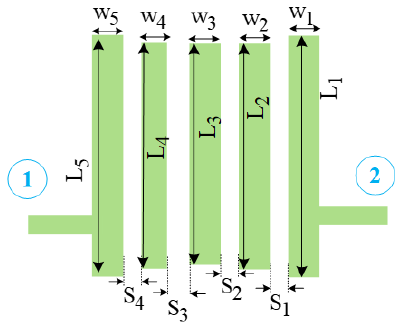
Figure 3. Structure of the general fifth-order interdigital filter.